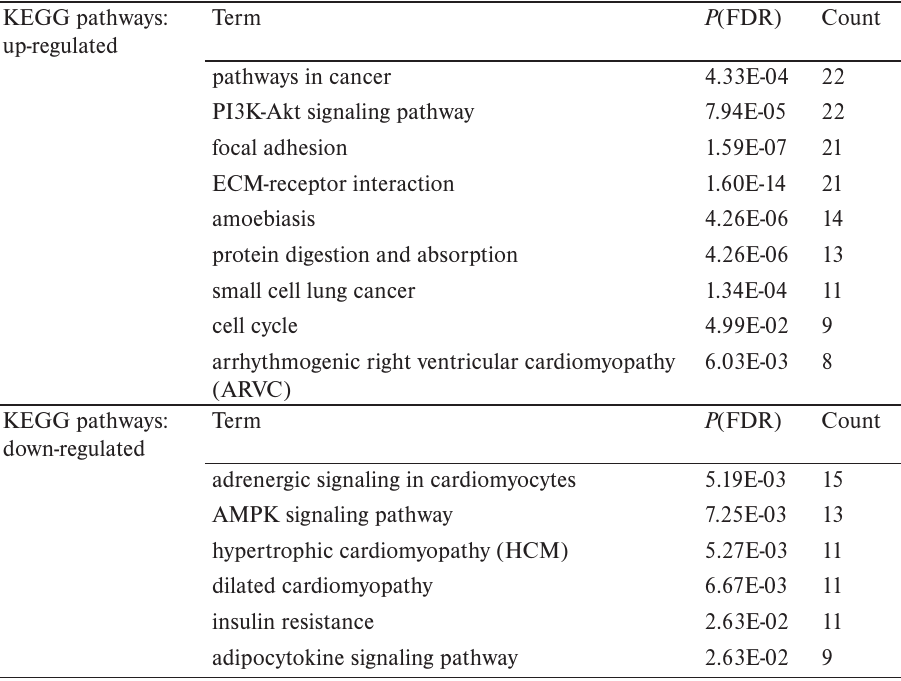
Table 3. Enrichment analysis of KEGG pathways in